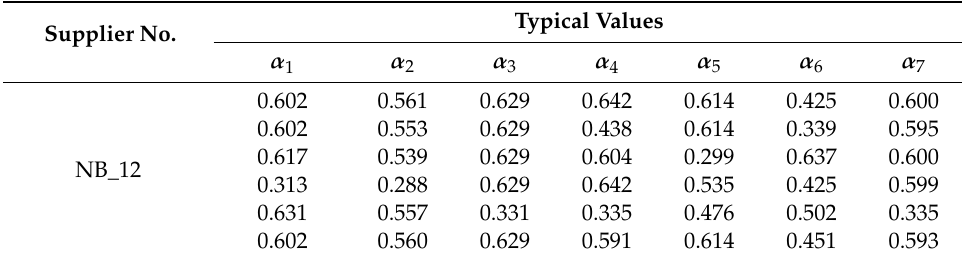
Table 2. Typical values of the metering equipment’ supplier NB_12. Supplier No.